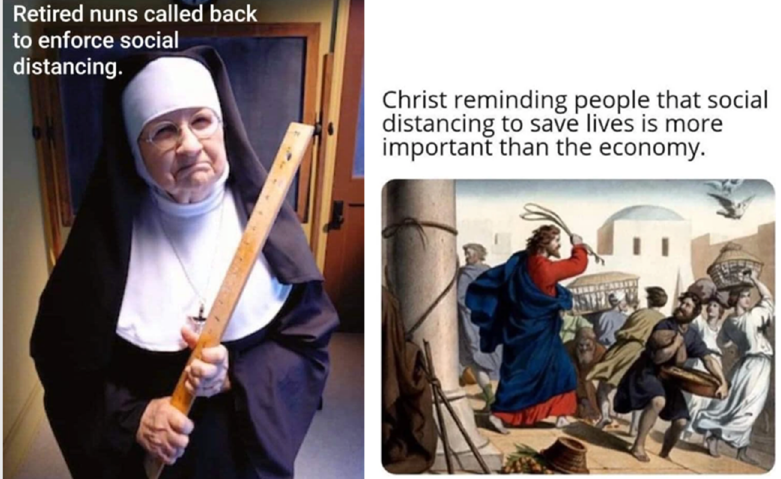
Figure 8. Examples of memes that depicit Christian leaders as unkind or violent in their response to enforcing social distancing.